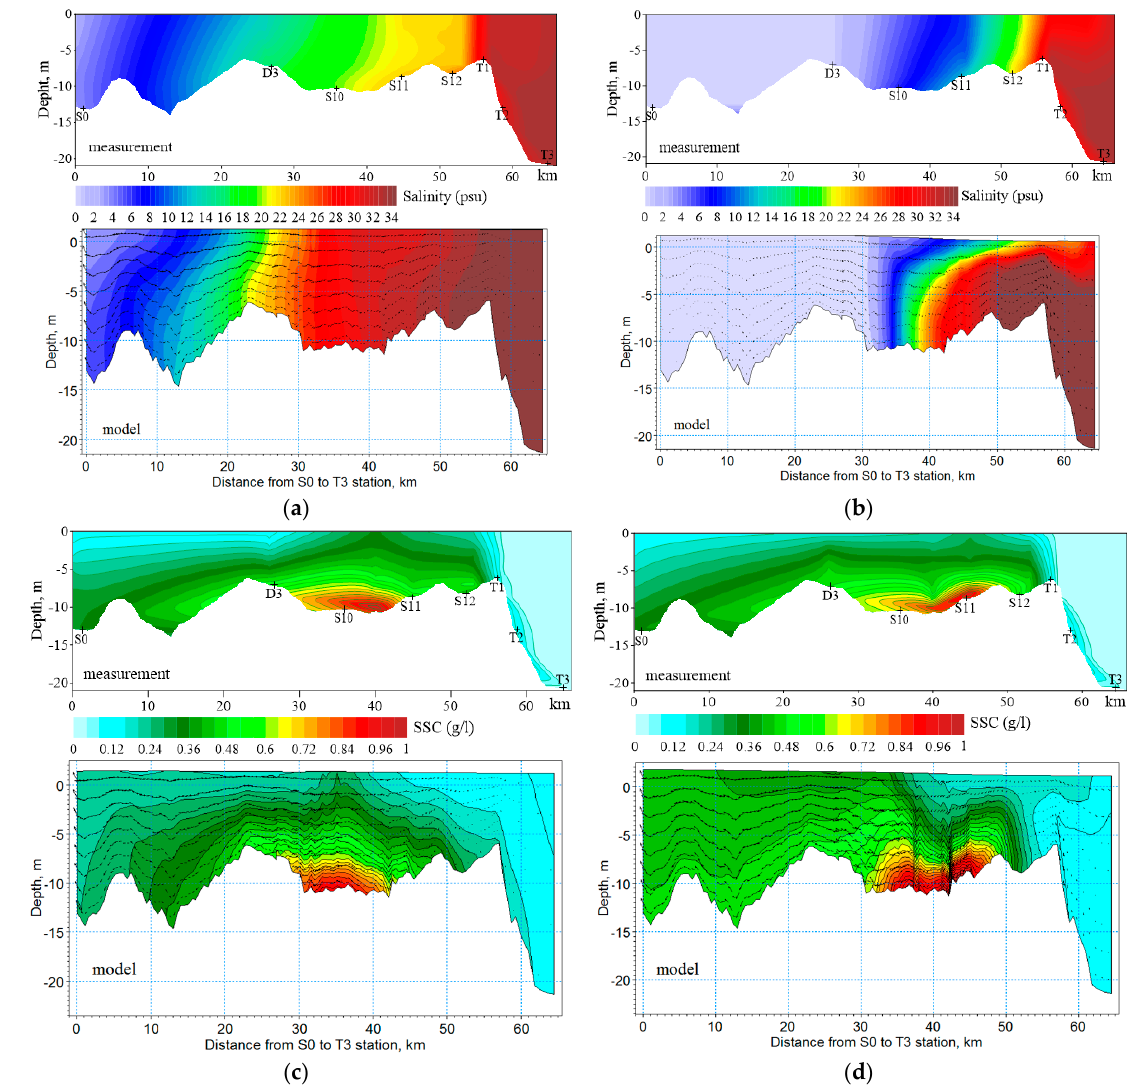
Figure 8. Along-channel salinity and SSC distribution at high tide: ( a ) salinity in the dry season; ( b ) salinity in the flood season; ( c ) SSC in the dry season; ( d ) SSC in the flood